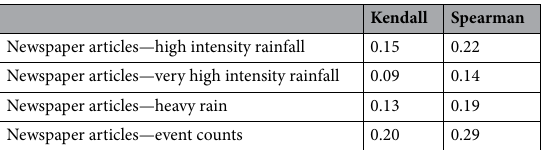
Table 1. Results of the nonparametric test for the analysed